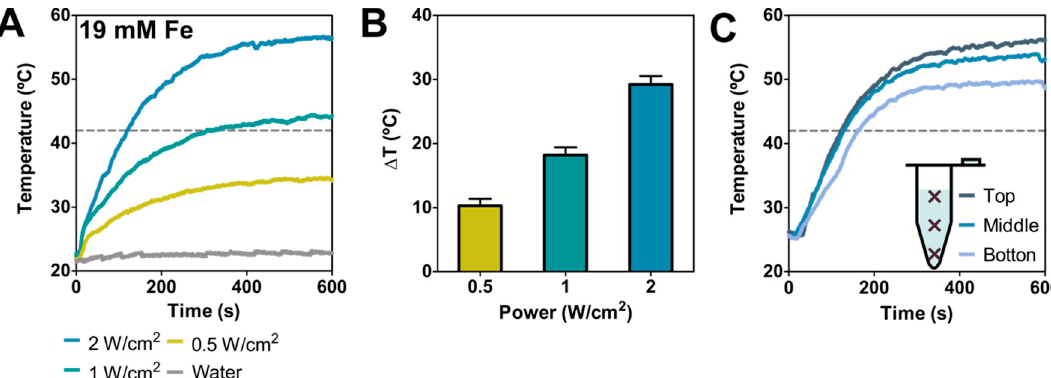
Figure 2. Nanoparticles’ photothermal response in suspension. ( A ) Temperature (measured at the top of the suspension) as a function of irradiation time at 0.5, 1 and 2 W cm − 2 ([Fe] = 19 mM and water as a control). ( B ) Temperature increases for different laser powers after 5 min of treatment. ( C ) Temperature as a function of irradiation time at 2 W cm − 2 ([Fe] = 19 mM) recorded at different distances from the irradiation point, being the “top” position.